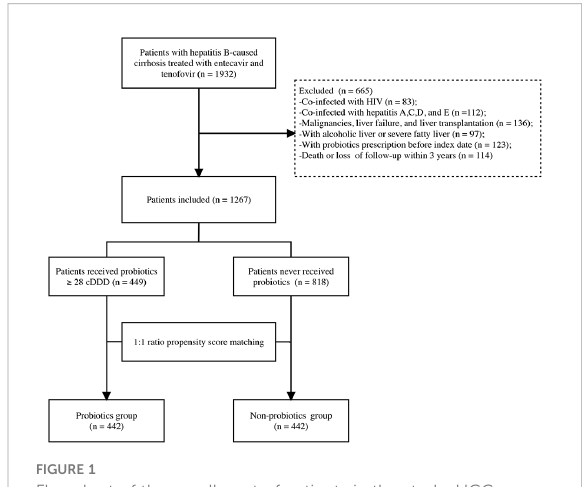
FIGURE 1 Flowchart of the enrollment of patients in the study. HCC, hepatocellular carcinoma; HIV, human immunode fi ciency virus; cDDD, cumulative de fi ned daily